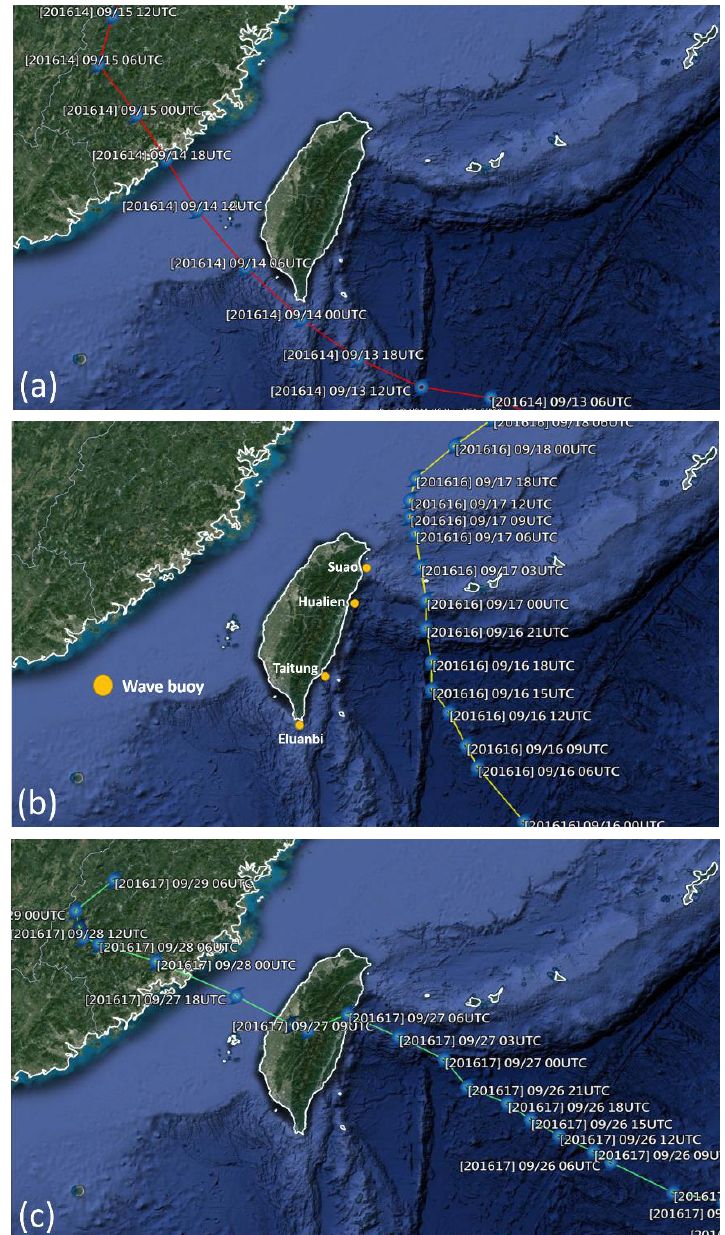
Figure 1. Tracks and arrival times of Typhoons ( a ) Meranti, ( b ) Malakas, and ( c ) Megi. The four yellow circles in ( b ) indicate the locations of the wave buoys.